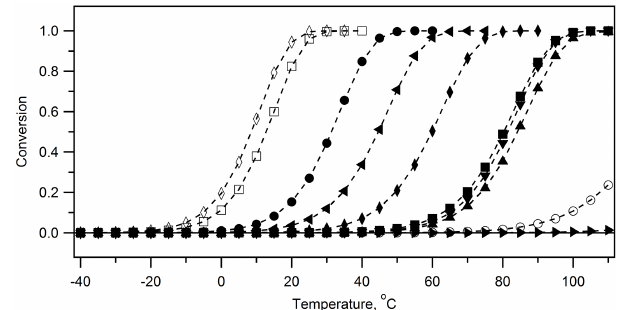
Figure 8. Thermal decomposition profiles of IONO 2 , (cid:7) ; BrONO 2 , (cid:73) ; HO (cid:74) ; C (cid:13) ; ClONO • ; N (cid:5) ; 2 , 2 NO 2 , 2 O 5 , 2 H 5 O 2 NO 2 , CH 3 C(O)CH 2 O 2 NO 2 , (cid:3) ; MPAN, (cid:4) ; PAN, (cid:78) ; and PPN, (cid:72) . Calcu- lated from IUPAC recommended kinetic data (Atkinson et al., 2004, 2006, 2007) using FACSIMILE kinetic modelling software (MCPA Software Ltd.) based on 1s residence time. Note that CH 3 O 2 NO 2 is not shown but has the same profile as CH 3 C(O)CH 2 O 2 NO 2